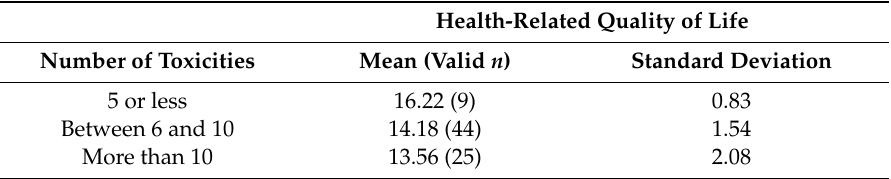
Table 1. Number of toxicities per patient per